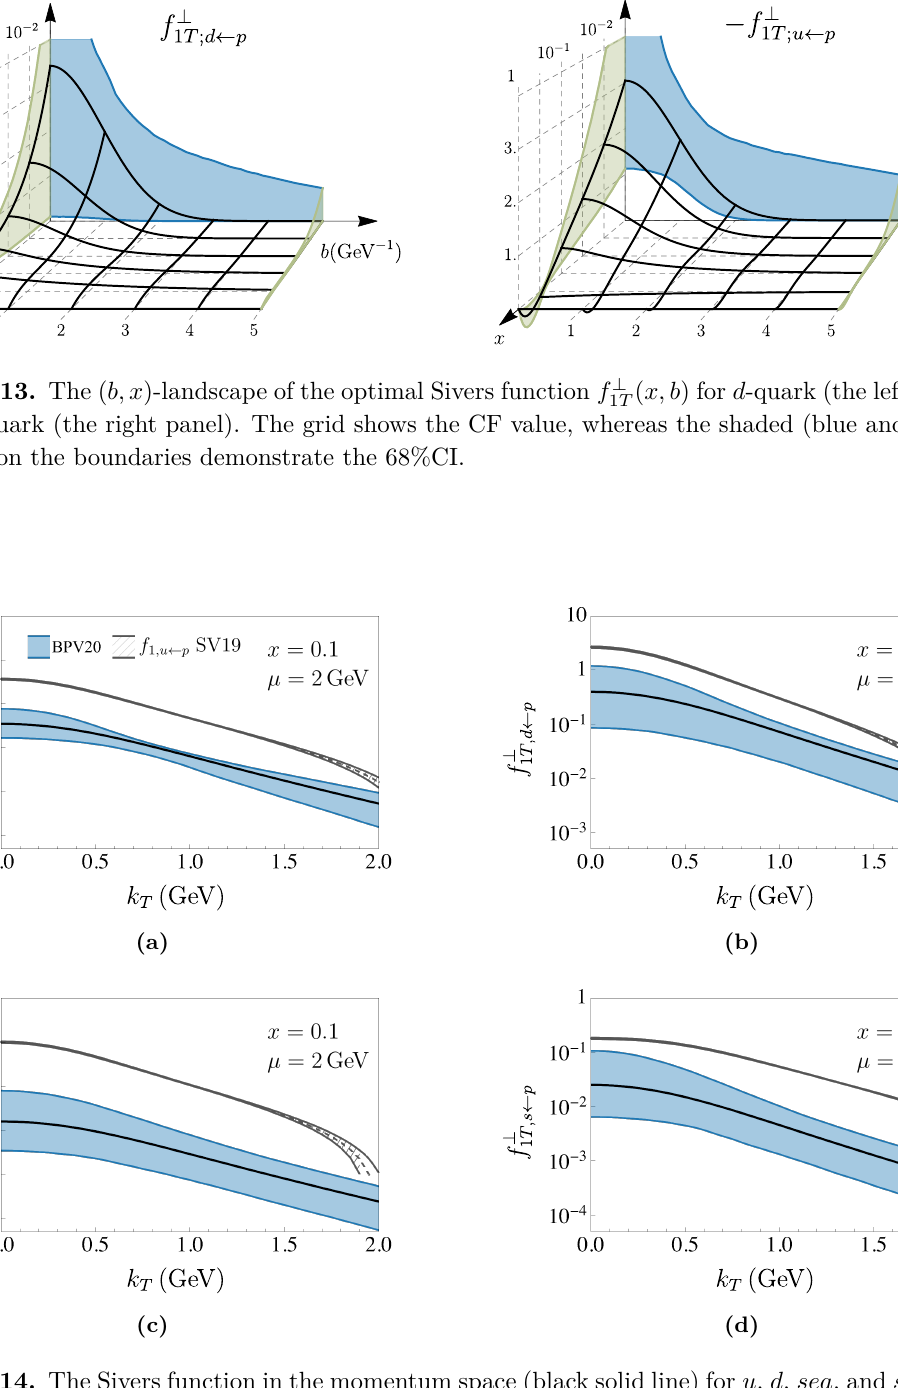
Figure 14. The Sivers function in the momentum space (black solid line) for u , d , sea , and s quarks at x = 0 . 1 and µ = 2 GeV. The blue band is the 68%CI. The gray dashed line is the unpolarized TMD PDF extracted in SV19 shown for the comparison (for u and sea -quark the Sivers function is multiplied by − 1 and sea -quark the Sivers function is compared to ¯ u unpolarized TMD